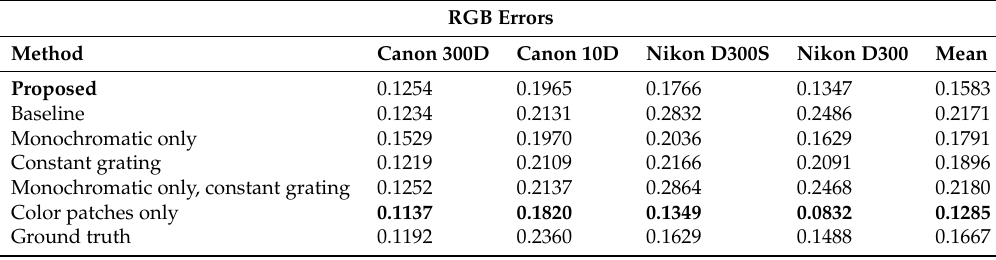
Table 1. Mean of absolute RGB channel relative residuals, relative to the mean of measured channel values for each camera, are presented here. Of all the considered variations of the method, the proposed method produces the second lowest channel errors in estimating the relative channel response—approximately 27% lower errors compared to the baseline. The lowest errors are produced using the color patches only method, which, however, requires ground truth spectral responses for training. Bolded values indicate lowest error for each